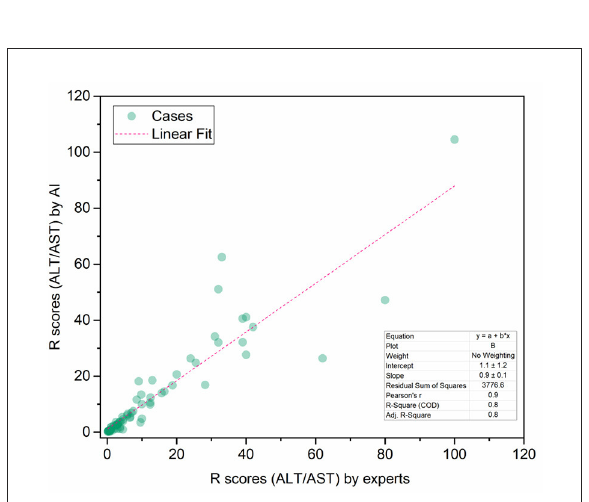
FIGURE5 The correction between the R scores (ALT/AST) calculated by DeepCausality and expert: ALT and AST stand for Alanine transaminase and aspartate transaminase,